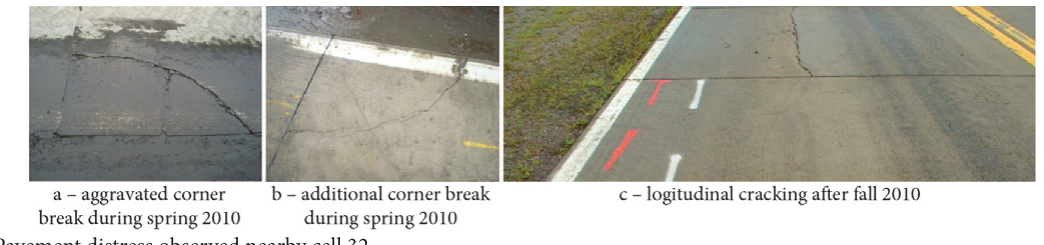
Fig. 4. Pavement distress observed nearby cell 32